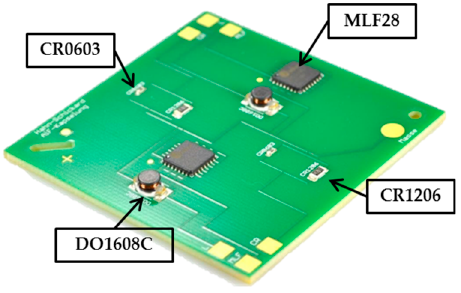
Figure 1. PCB with mounted devices (CR1206, CR0603, MLF28, DO1608C).